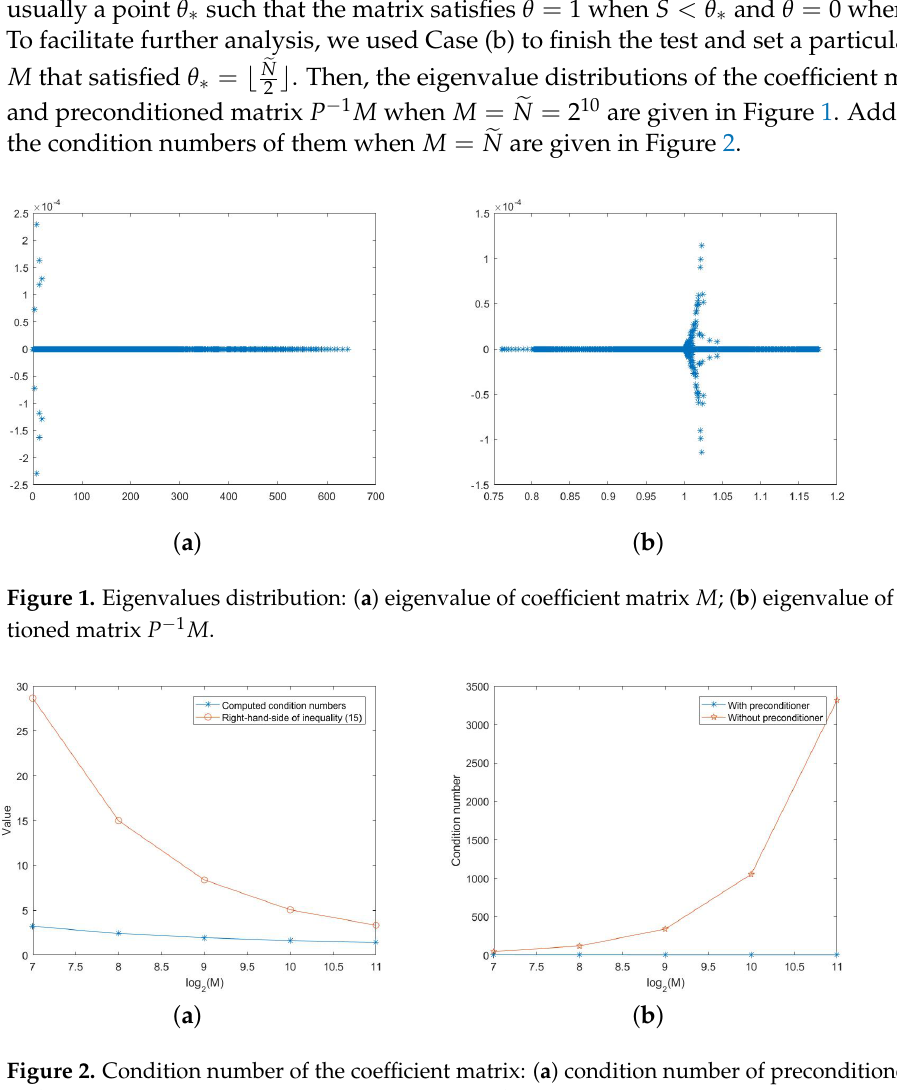
Figure 2. Condition number of the coefficient matrix: ( a ) condition number of preconditioned matrix P − 1 M ; ( b ) comparison of condition number of P − 1 M and M